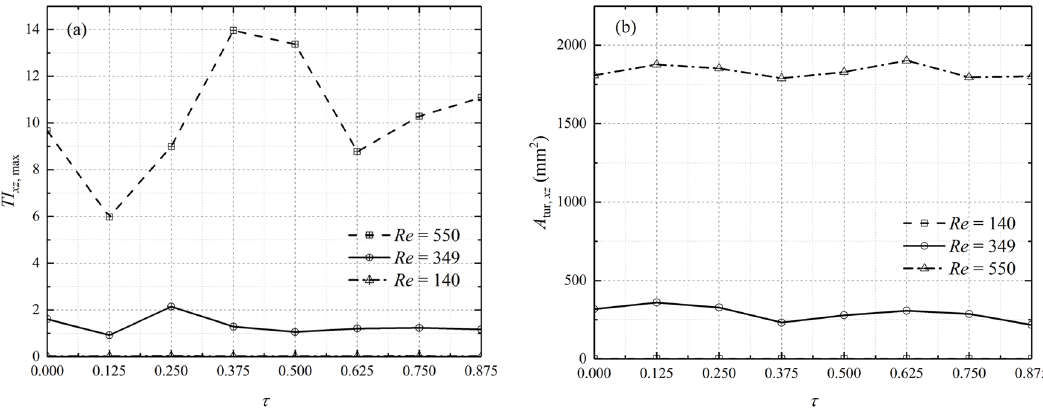
Figure 17. Turbulence characteristics during one cycle at different Reynolds numbers: ( a ) maximum turbulence intensity TI xz , max and ( b ) influencing area of turbulence A tur, xz at different phases.